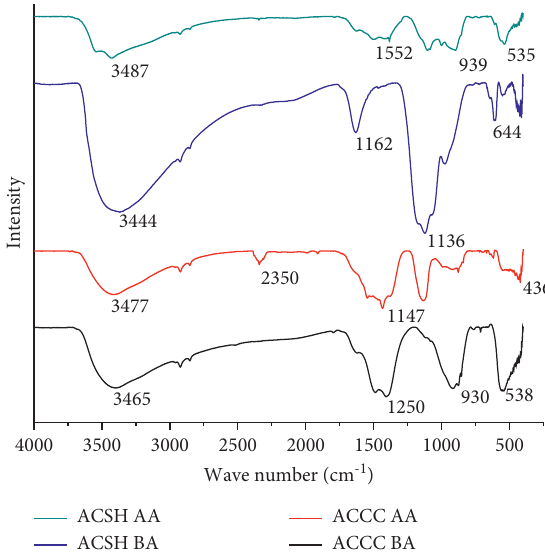
Figure 1: The FTIR spectra for activated carbon of corncob before adsorption (ACCC BA), activated carbon of corncob after ad- sorption (ACCC AA), activated carbon sorghum husk before adsorption (ACSH BA), and activated carbon sorghum husk after adsorption (ACSH